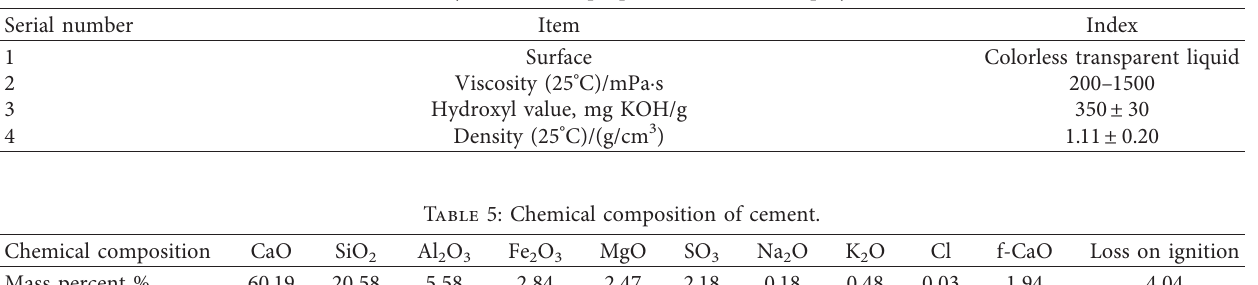
Table 4: Physicochemical properties of combined polyether.